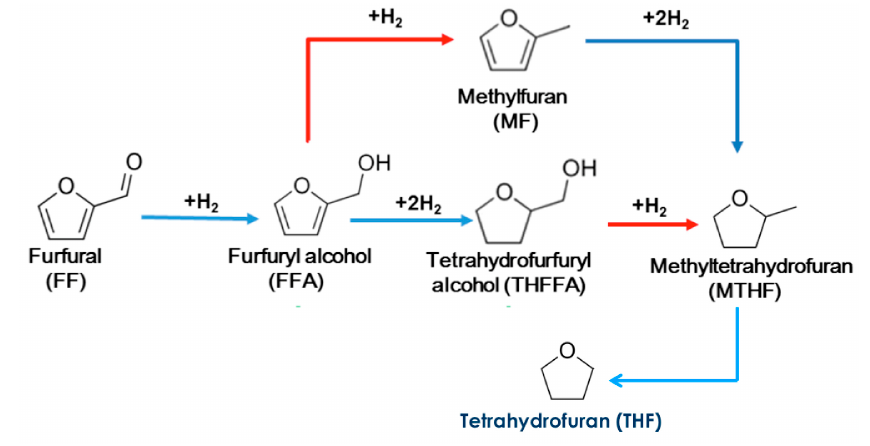
Figure 6. Possible products of the furfural hydrogenation (reprinted from [54]). 216